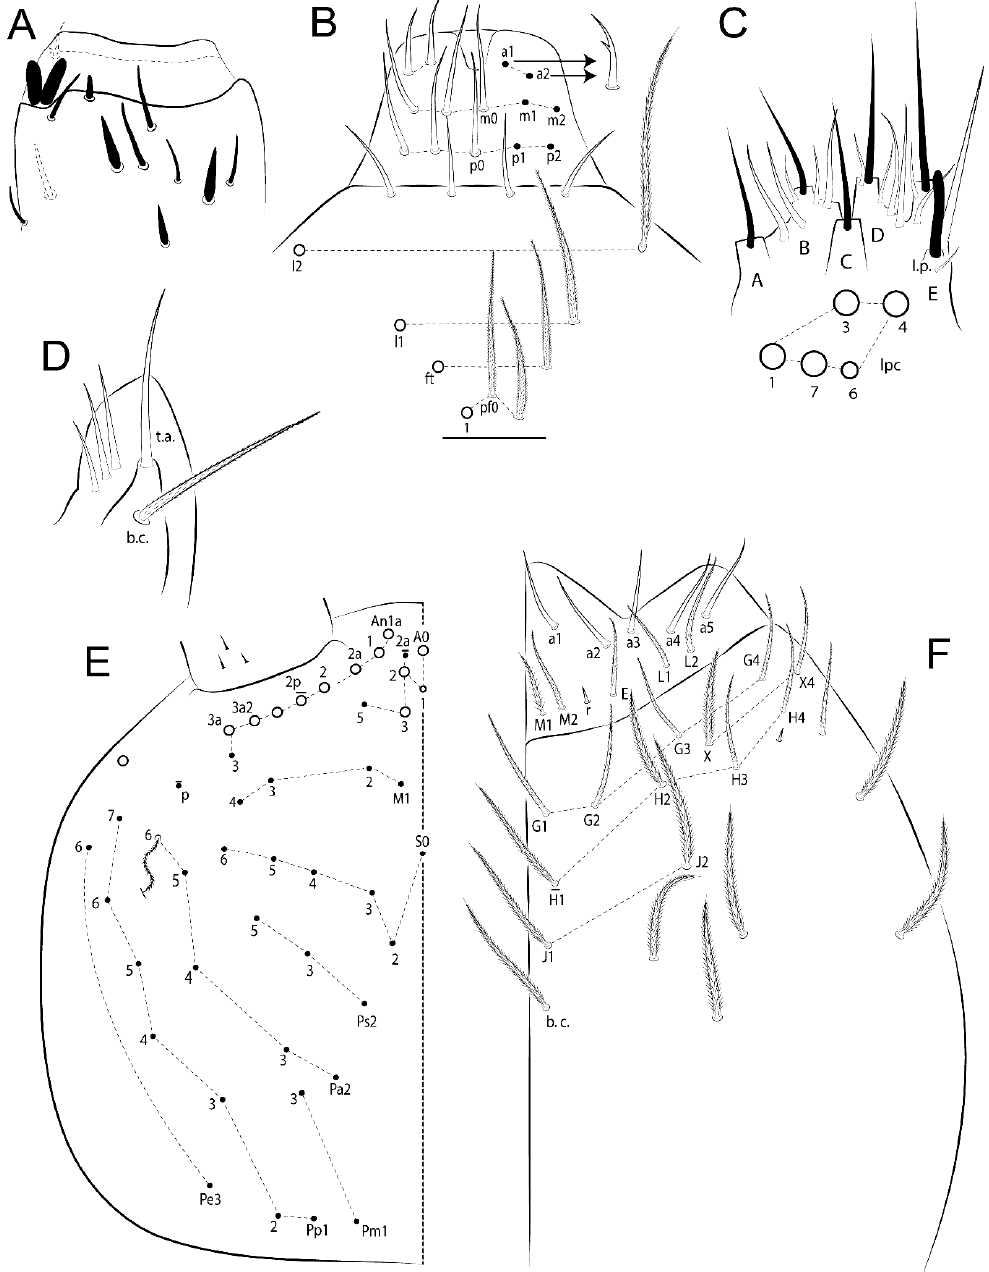
Figure 52. Pseudosinella mitodentunguilata sp. nov.: head. ( A ) Ant III apical organ (ventro-lateral view); ( B ) chaetotaxy of clypeus, prelabrum, and labrum; ( C ) labial papillae (H omitted) plus proximal chaetae (right side); ( D ) maxillary palp and sublobal plate (right side), minute appendage omitted; ( E ) head dorsal chaetotaxy (left side); ( F ) basomedian and basolateral labial fields and complete postlabial chaetotaxy (right side).